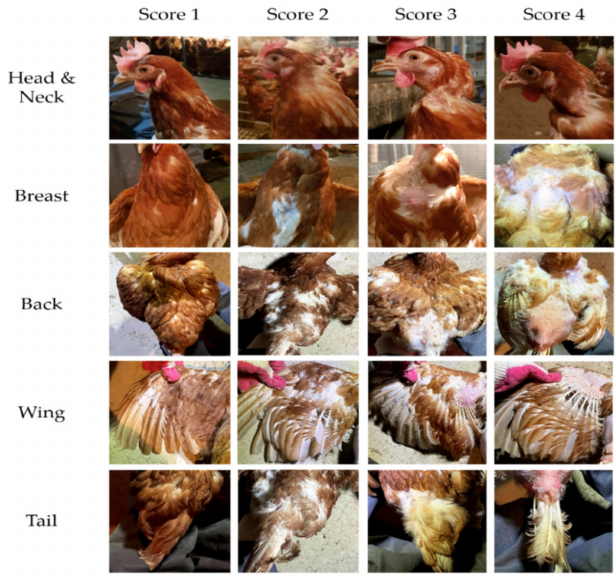
Figure 2. Score based on feather quality for each part of the laying